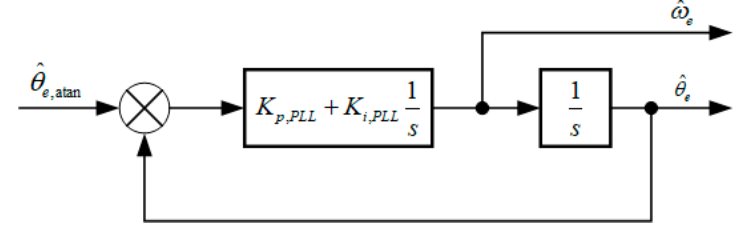
Figure 3. Structure of the PLL observer.